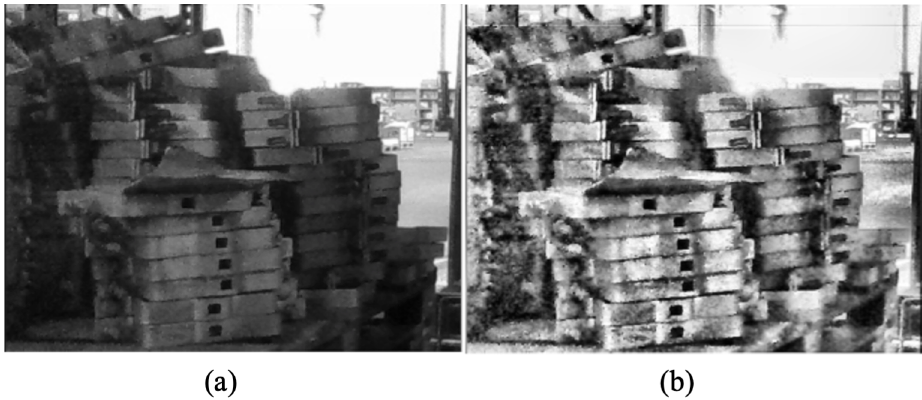
Figure 4. Enhancing image features: ( a ) original image and ( b ) adaptive histogram